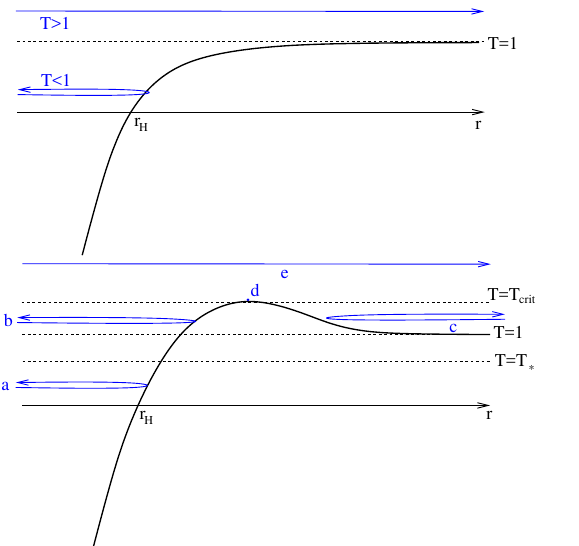
Figure 11 . E(cid:11)ective potential V ( L ) and types of Lorenzian ETW brane trajectories for d = 2 (left) and d > 2